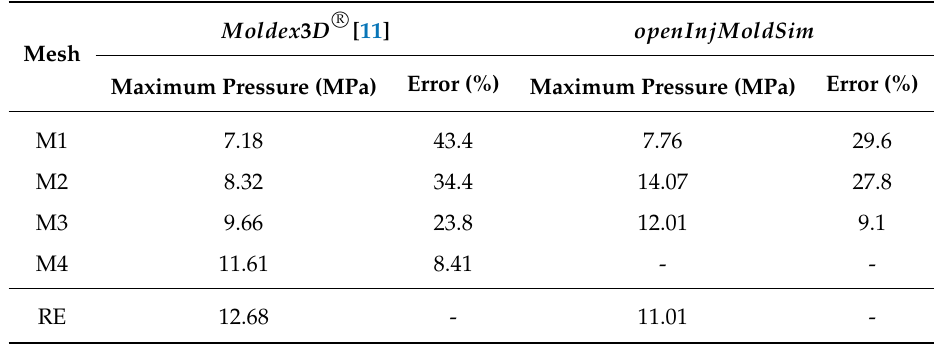
Table 12. Maximum pressure values obtained with the proprietary software Moldex 3 D R the open-source software openInjMoldSim at the switch-over point. The Richardson’s extrapolated (RE) values and the relative errors are also